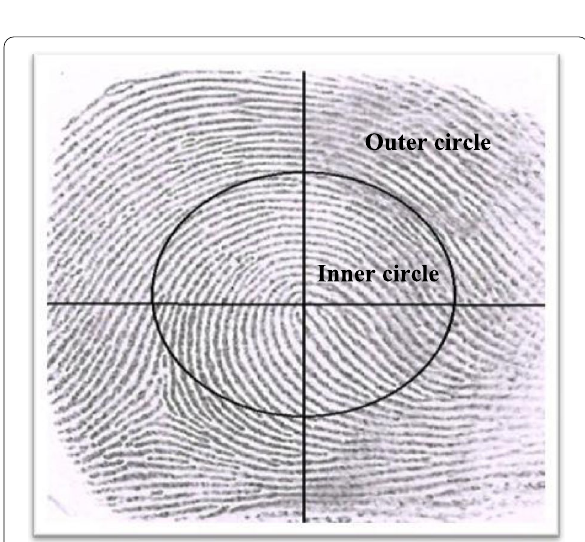
Fig. 2 Thumbprint showing two topological areas of thumb print, i.e., inner circle and outer